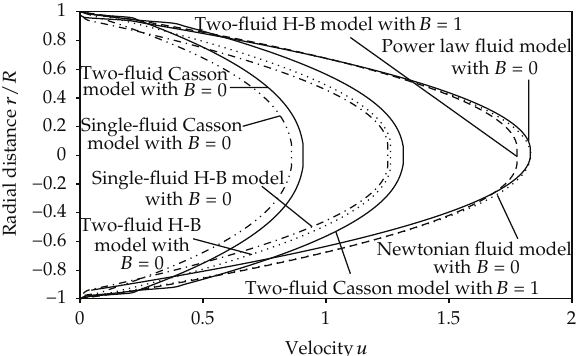
Figure 6: Velocity distribution for di ff erent fluid models and di ff erent values of B with n (cid:7) β (cid:7) 0 . 95, t (cid:7) 210 ◦ , b (cid:7) 0 . 1, δ P (cid:7) θ (cid:7) 0 . 1, e (cid:7) 0 . 5, φ (cid:7) α (cid:7) α H (cid:7) α C (cid:7) 0 . 2, ω (cid:7) 1, z (cid:7) 2 . 3 and ψ (cid:7) − 0 . 05.